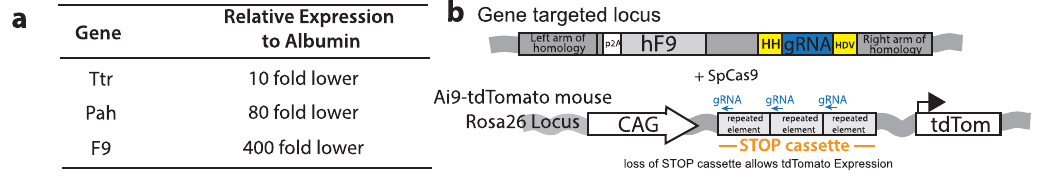
e Representative liver sections and f fl ow cytometry plots showing tdTomato positive hepatocytesinmice thatreceived rAAV-GRasadults.Quanti fi cationofthe tdTomatopositivehepatocytesasmeasuredby fl owcytometryinmicethatreceive the various targeting rAAV-GR as g neonates and h adults. Scale bars represent 100 µ m. Biologicallyindependent micewere analyzed. Data are presented asmean valuesanderrorbarsrepresentstandarddeviation.Statisticswerecalculatedusing an ordinary one-way ANOVA with Tukey ’ s multiple comparisons test. * P <0.05, ** P <0.01 and *** P <0.001. Source data are provided as a Source Data fi